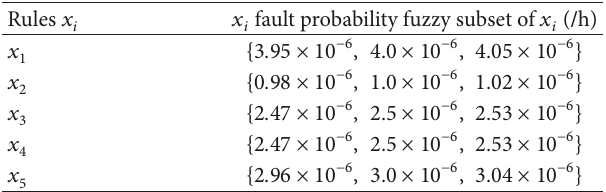
Table 4, where the central value of every fuzzy probability subset is the maximum possible value of probability of fault, and the left is the lower limit, and right is the upper limit.